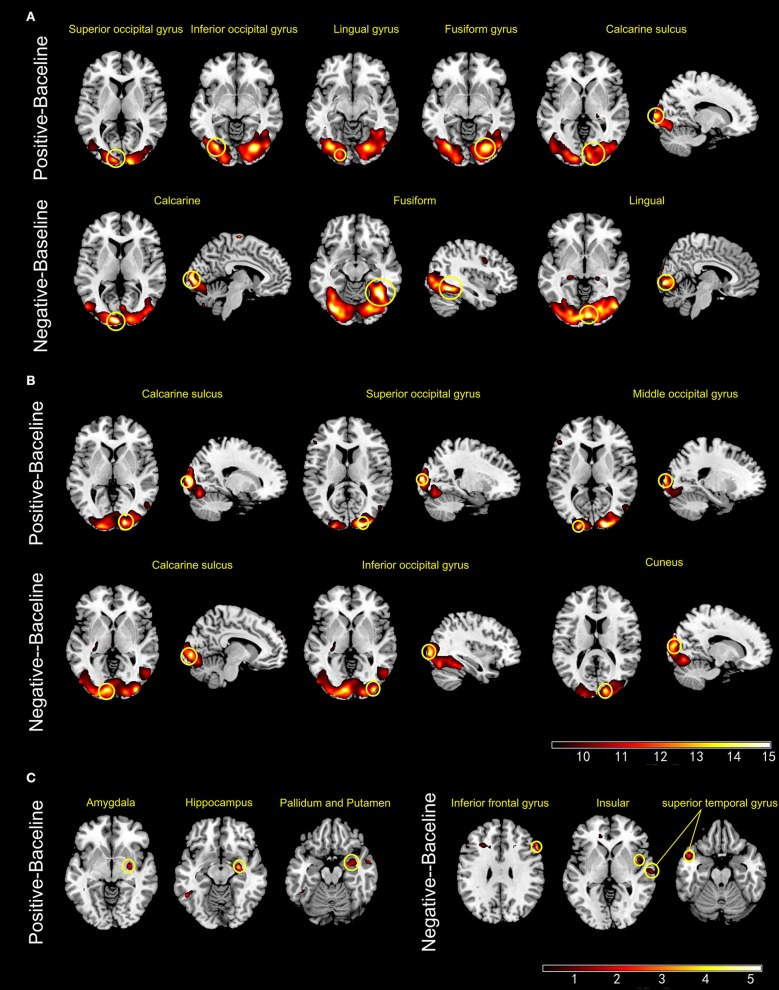
Panels (A,B) show the active brain regions during emotional picture sessions in healthy controls (A) and patients with bipolar disorder (B). Panel (C) shows areas that exhibited significant increase in BOLD signal intensity (BPs > HCs) (p < 0.001, uncorrected).